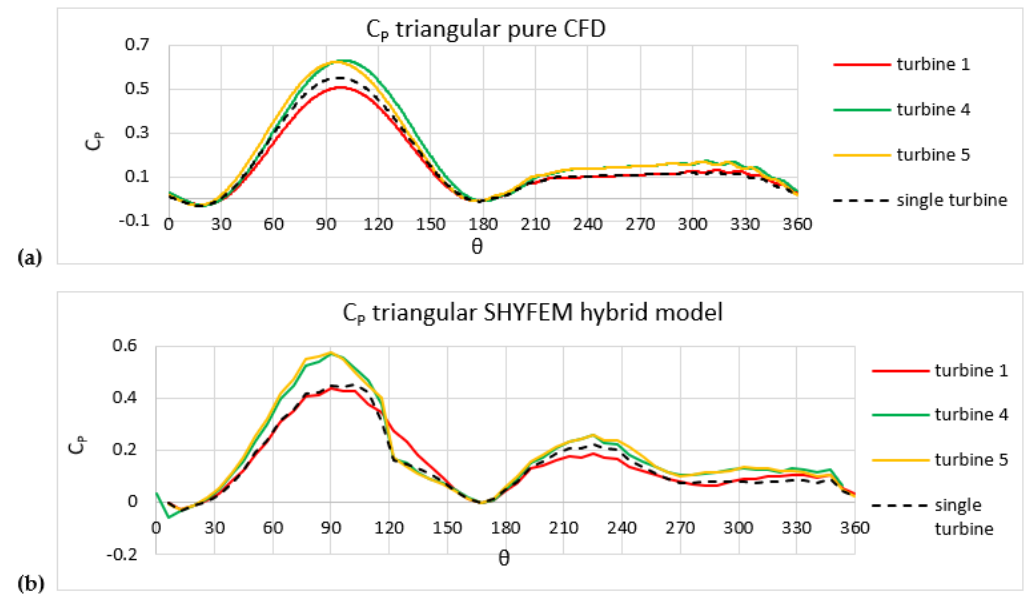
Table 4. Percentage changes in the performance of triads. Figure 18. C P for the triangular triad both for the purse CFD ( a ) and SHYFEM hybrid model ( b ).